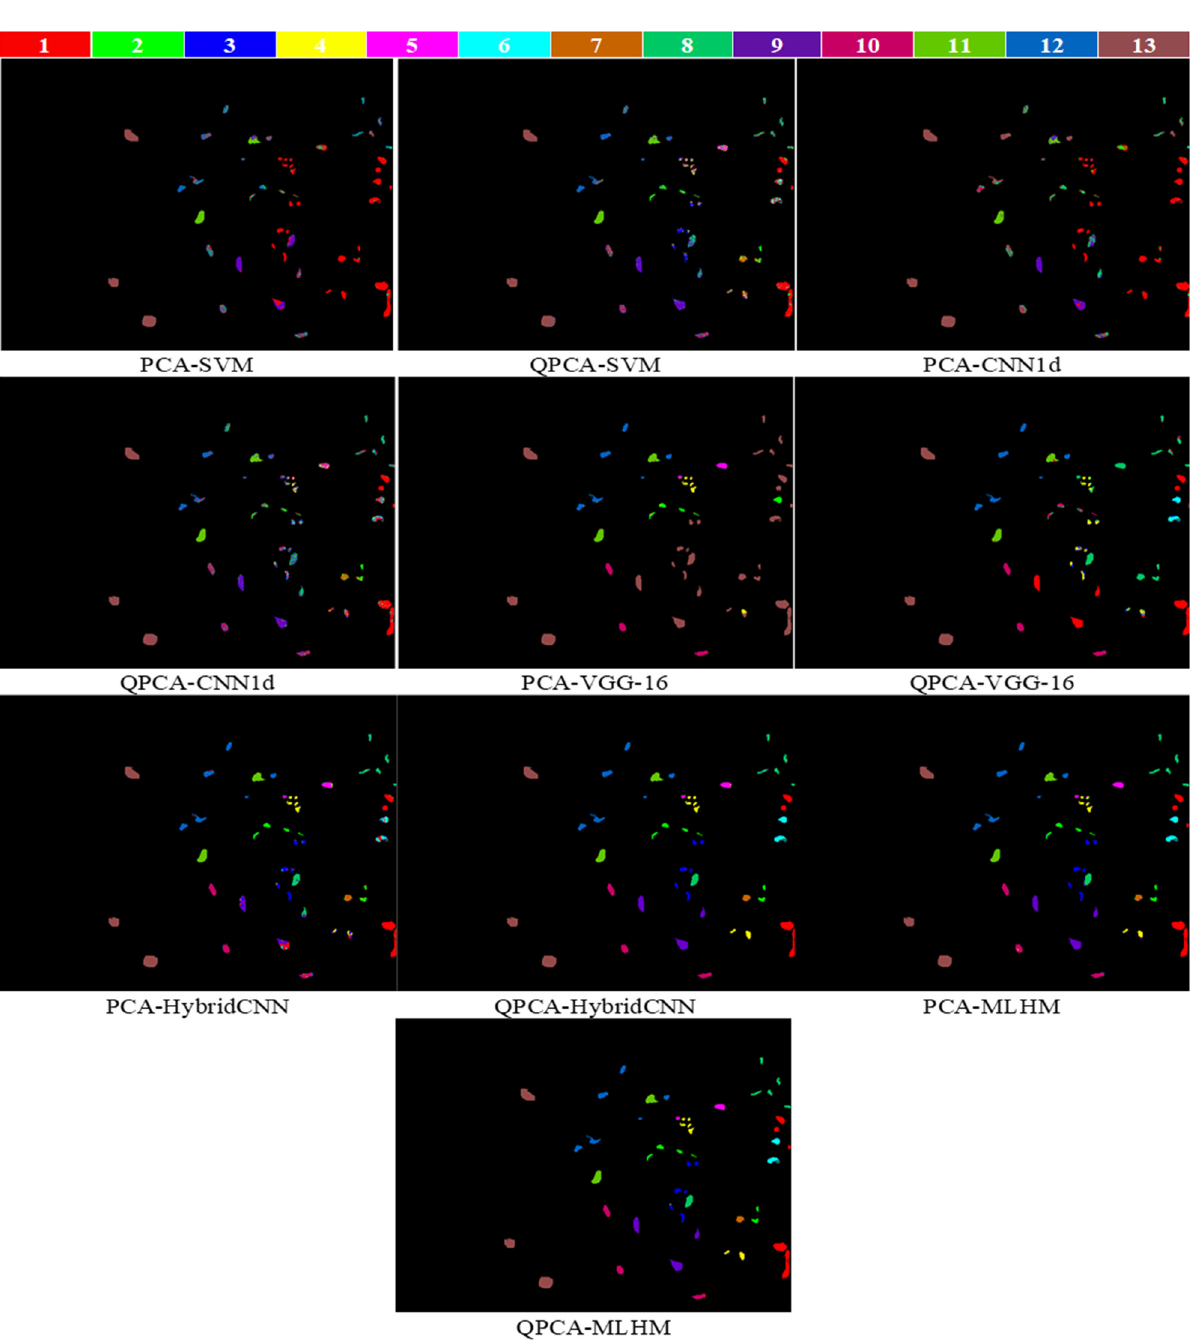
Figure 10. The output of the various models with PCA and QPCA preprocessing for the KS_Center dataset. KS_Center